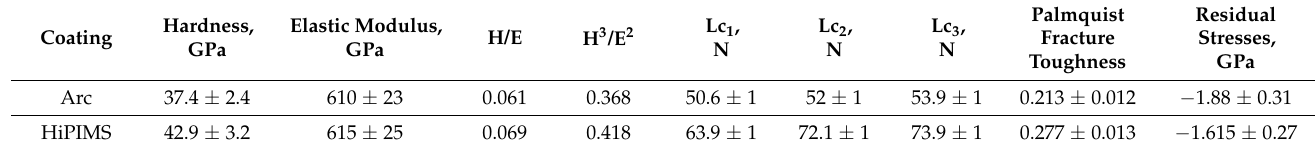
Figure 5. TEM images with SAED diffraction patterns of AlTiN ( a – c ) HiPIMS and ( d − f ) CAD coatings. Micromechanical characteristics of the studied coatings are presented in Table 3. Table 3. Micromechanical characteristics of the studied coatings.